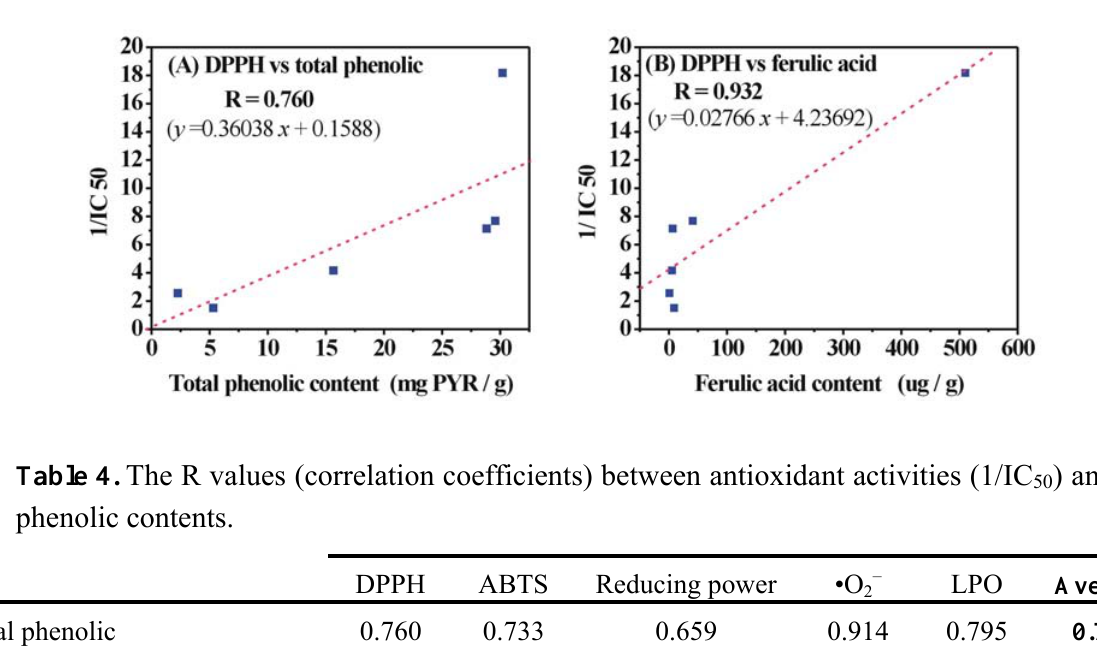
Figure 5. Correlation graphs for DPPH 1 /IC ferulic acid contents in the six RAS extracts.